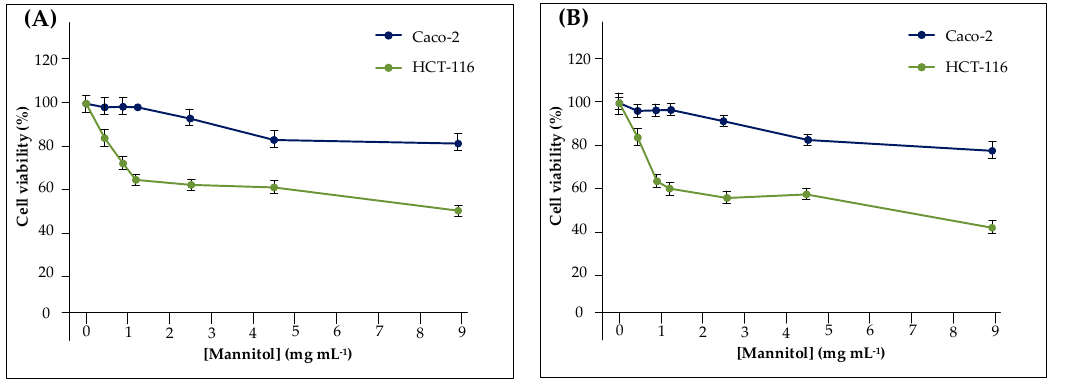
Figure 6. Caco ‐ 2 and HCT ‐ 116 cytotoxicity under different mannitol concentrations (0, 1.0, 1.2, 2.43, Figure 6. Caco-2 and HCT-116 cytotoxicity under di ff erent mannitol concentrations (0, 1.0, 1.2, 2.43, 4.5, 4.5, 9.0 mg mL − 1 ). MTT (3 ‐ (4,5 ‐ dimethylthiazol ‐ 2 ‐ yl) ‐ 2,5 ‐ diphenyltetrazolium) cell viability after 24 9.0 mg mL − 1 ). MTT (3-(4,5-dimethylthiazol-2-yl)-2,5-diphenyltetrazolium) cell viability after 24 ( A ) ( A ) and 48 h ( B ) exposure. and 48 h ( B )